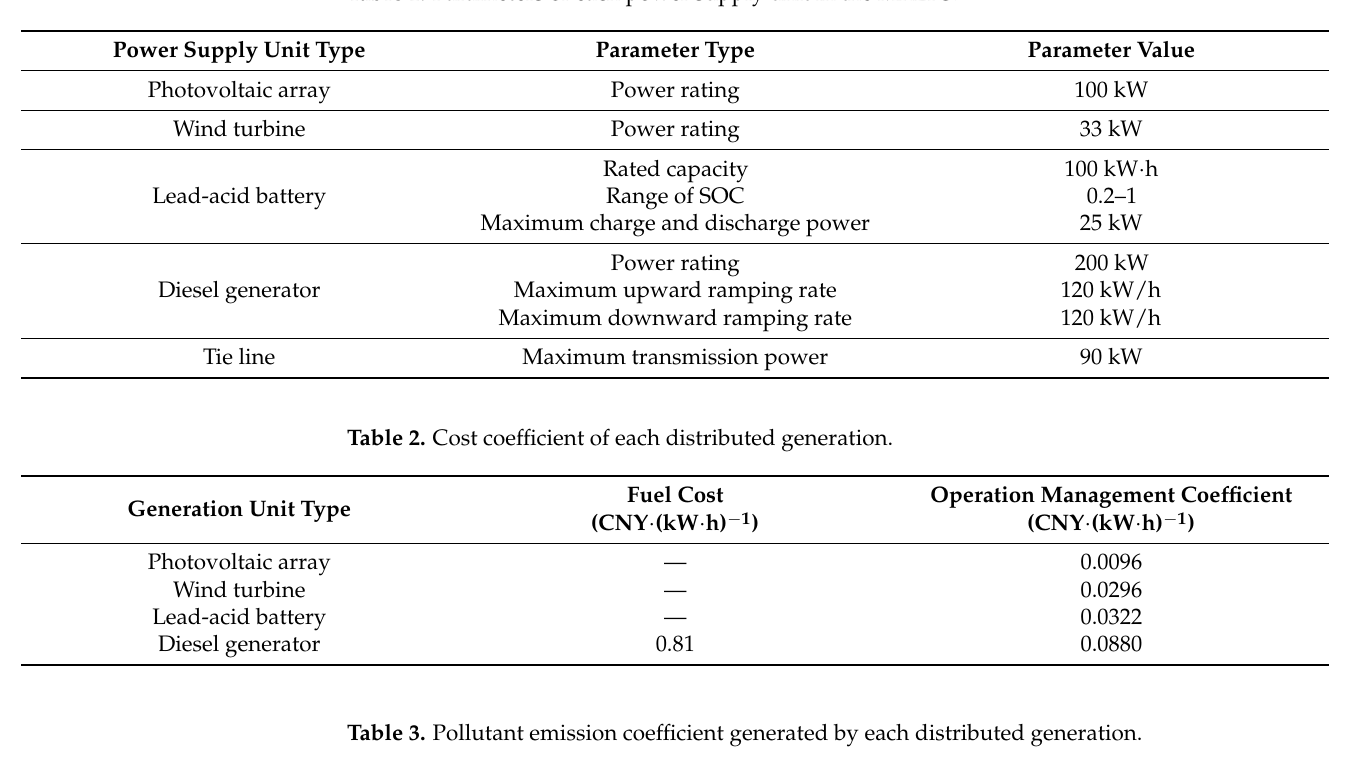
Table 1. Parameters of each power supply unit in the MREPS.